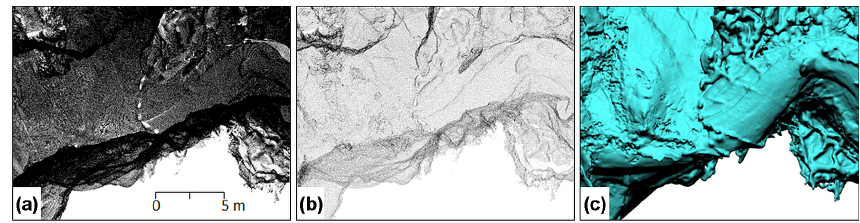
Figure 4. Point cloud from the Gothic Dome orthogonally projected on a horizontal plane representing 2% of the full resolution as exported from the SCENE project (a) , after subsampling the points at 5cm minimal spacing (b) , and as a continuous 3-D cave surface model (c) generated from (b) with the octree depth of